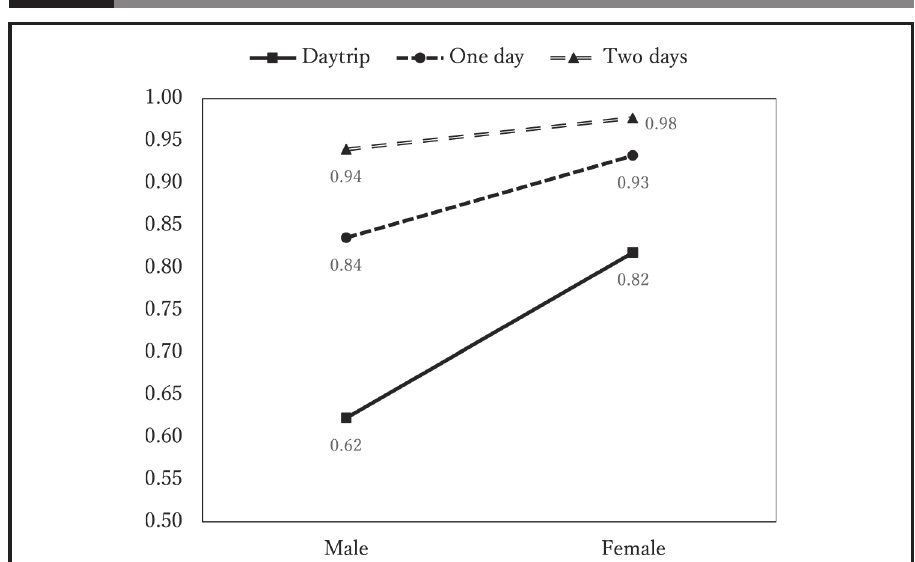
Figure 4 Probabilities of ‘‘Concerned’’ upon ‘‘Gender’’ and